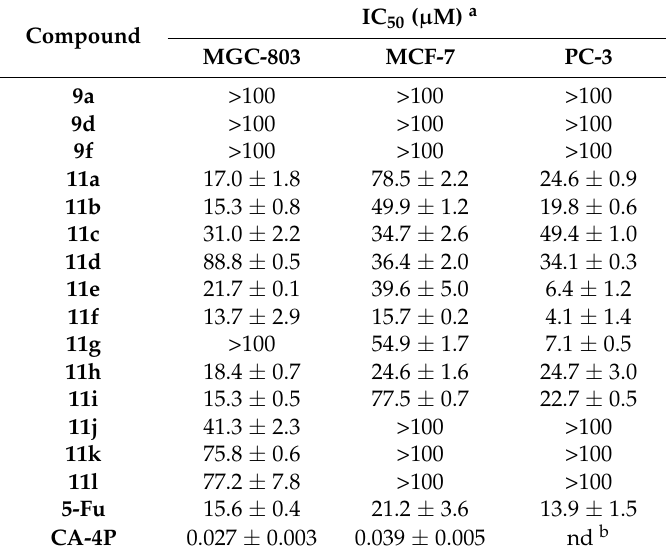
Table 1. Antiproliferative results of the target